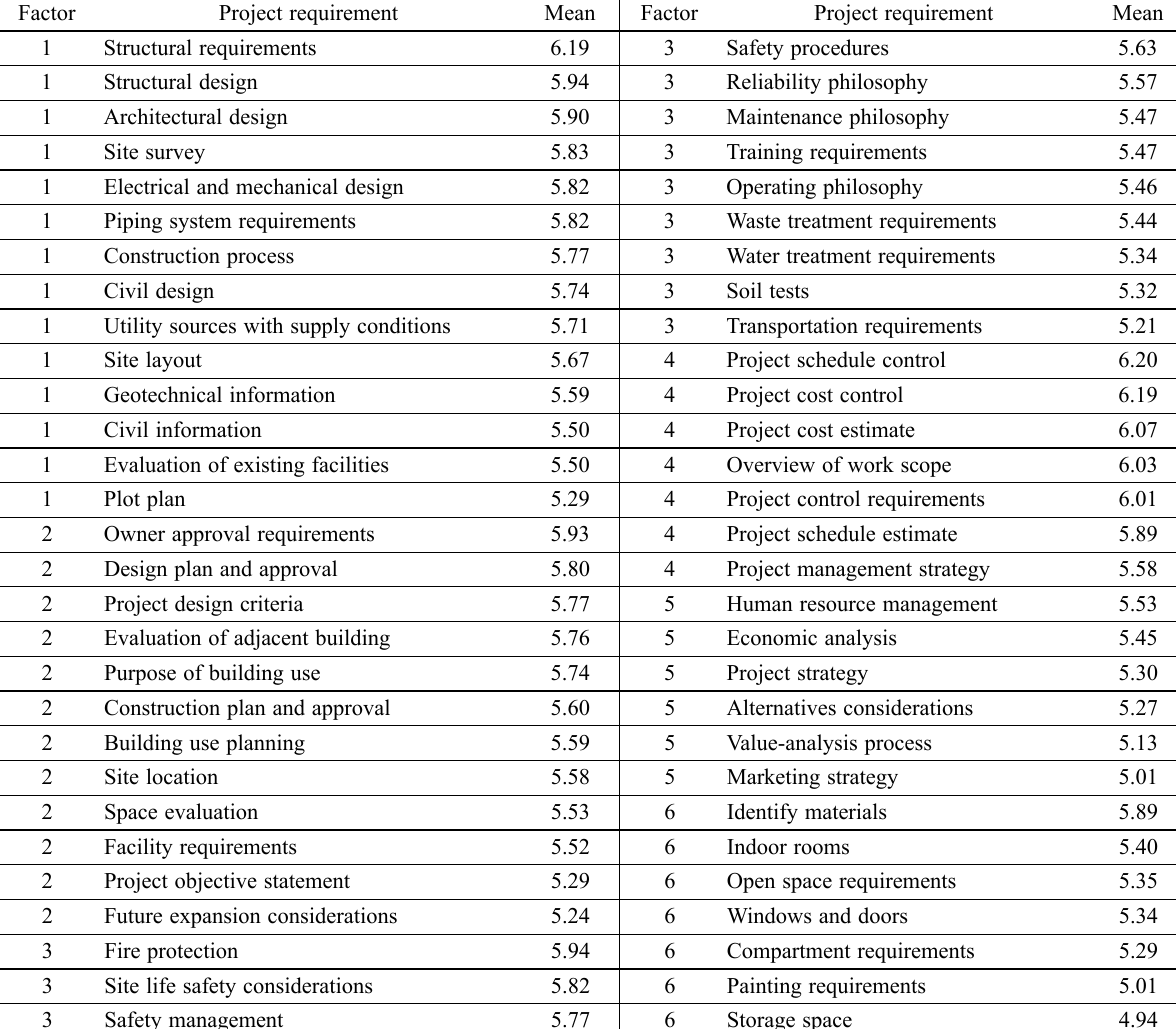
Table 2. Relative importance of project requirements for the categories